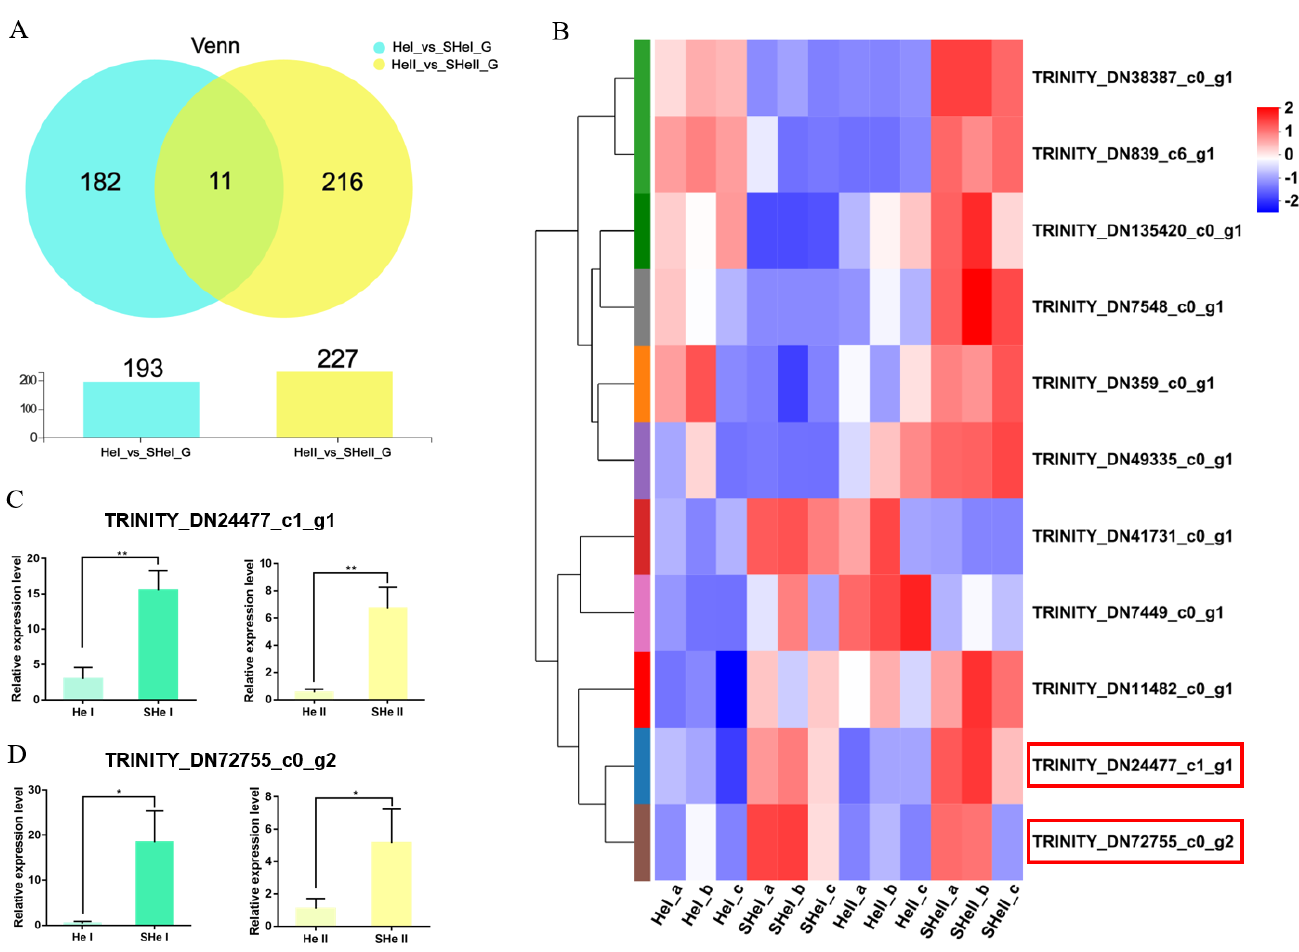
Figure 6. DEGs in the hepatopancreas. ( A ) Venn diagram of DEGs at 1 and 6 days after eyestalk ablation in E. carinicauda . ( B ) Heatmap of the 11 overlapping genes. ( C ) Validation of TRIN- ITY_DN24477_c1_g1 and ( D ) TRINITY_DN72755_c1_g1 expression levels by real-time PCR at dif- ferent timepoints (* p < 0.05, ** p < 0.01).